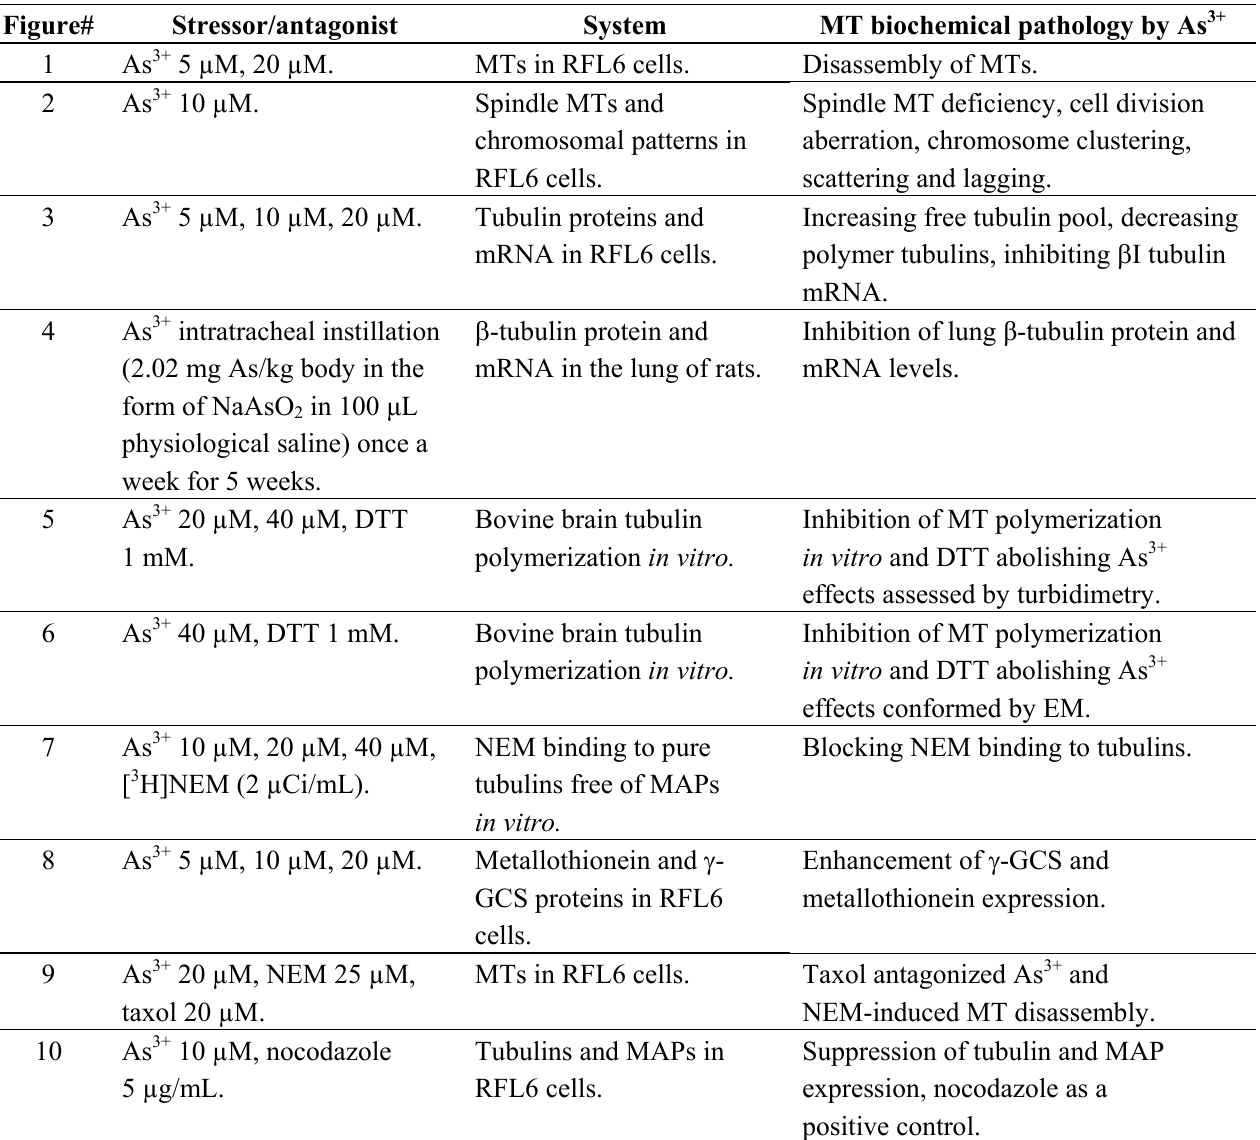
Table 1. Summary for As 3+ -elicited MT Biochemical Pathology. Figure# Stressor/antagonist